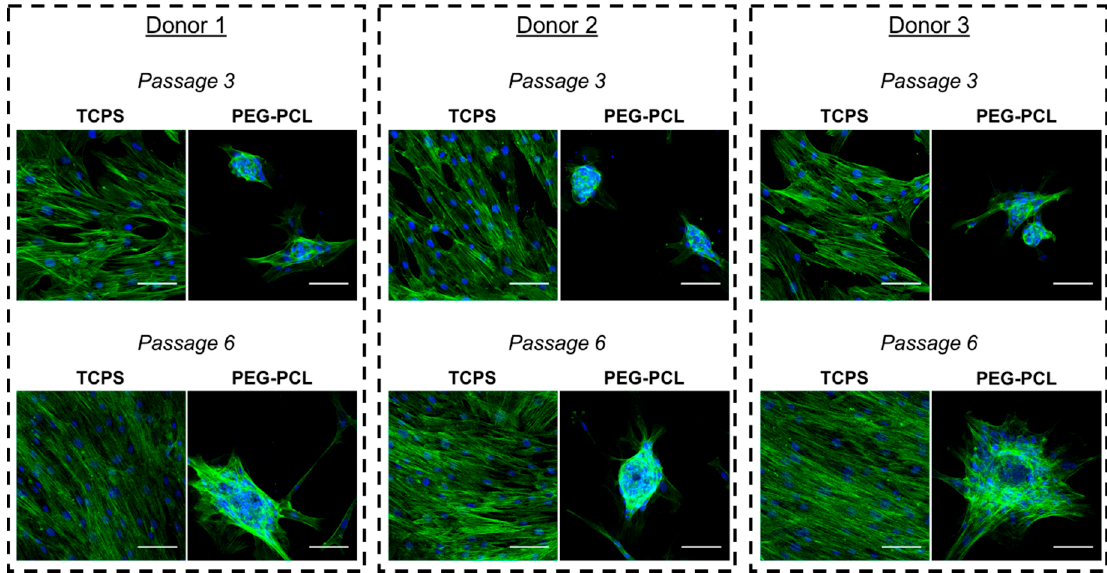
Figure 2. Morphological changes occur over serially passaging human mesenchymal stem cells on their respective substrates. Cells were stained with AlexaFluor-488-conjugated phalloidin (green) and Hoechst nuclear counterstain (blue). Scale bar = 100 μ m.